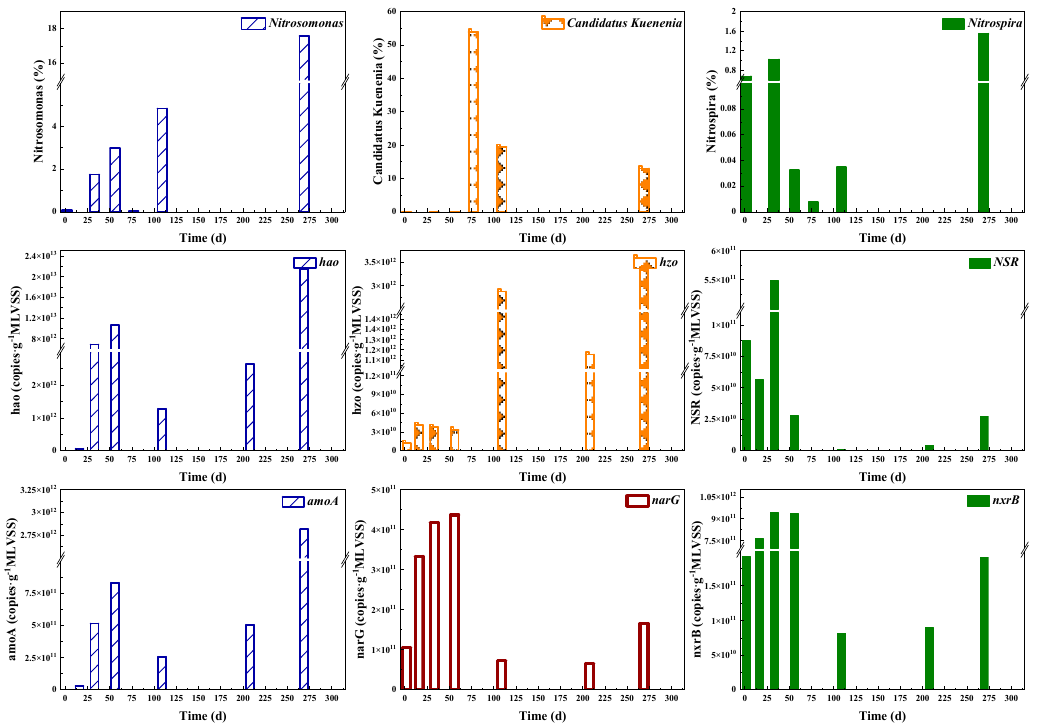
Figure 4. The abundances of nitrogen conversion functional bacteria and genes abundance.